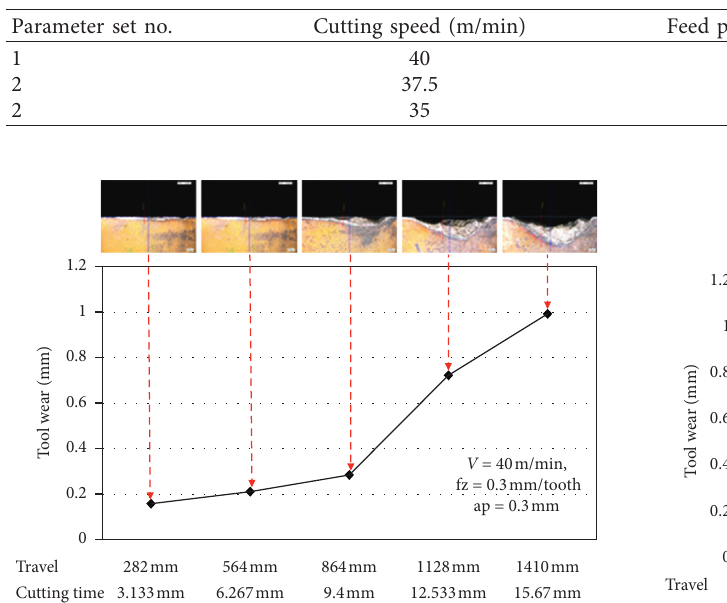
Figure 6: Experimental procedure. Table 1: Cutting condition design.